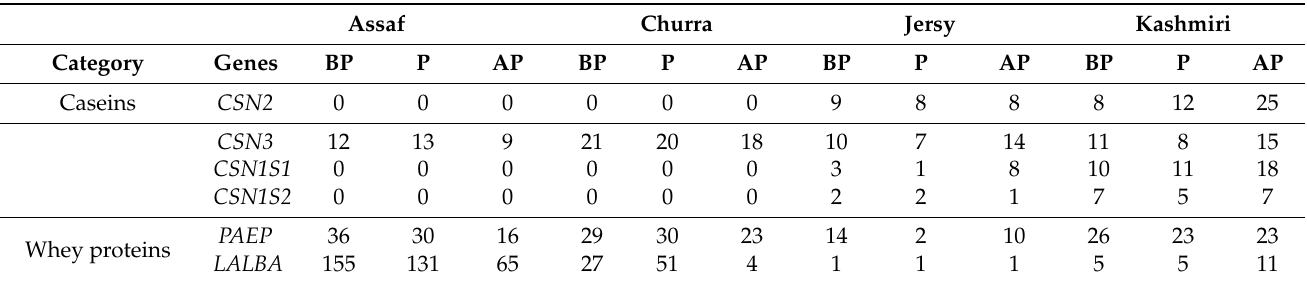
Table 5. Annotated functionally relevant variants in genes coding for major milk proteins for sheep and cattle breeds at different stages of